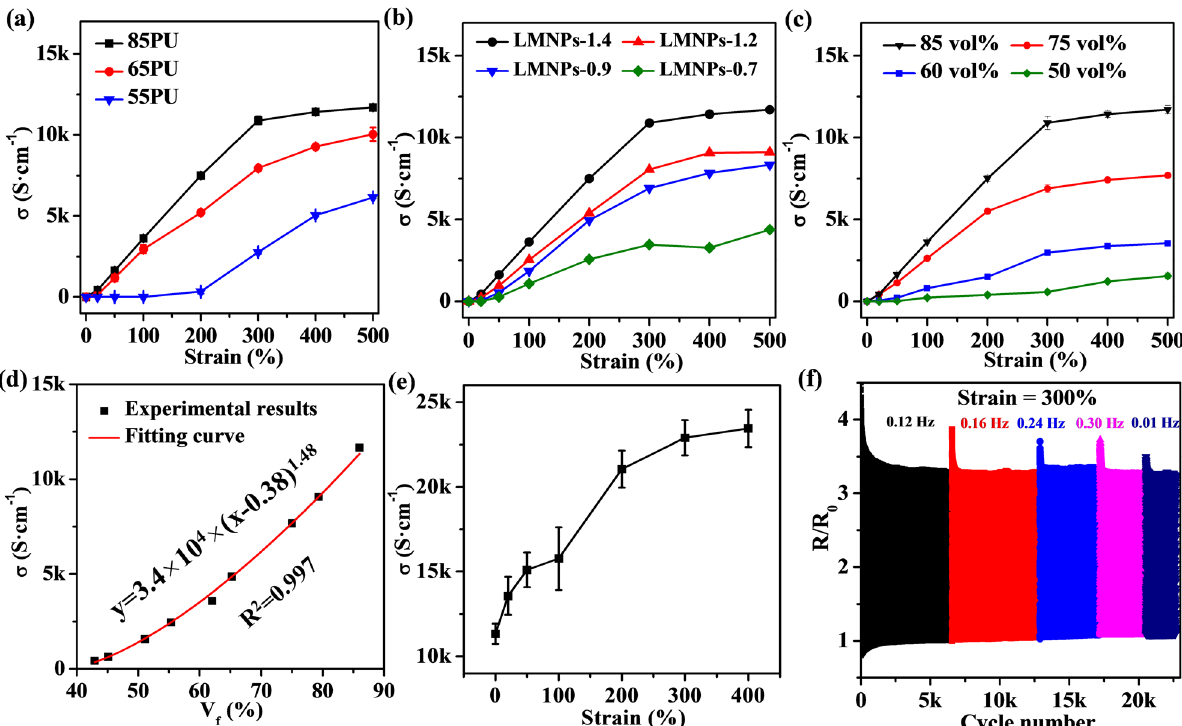
Fig. 3 Electrical performance of LM-based stretchable conductors. Relationship of conductivity in the releasing state (0% strain) after certain strains with a PU, b LMNPs diameters, and c LMNPs volume percentage. d Fitting of the experiment data with the percolation theory. e Conductivity-applied strain curve of 85%LMNPs-1.4/85PU. f Normalized resistance changes of 85%LMNPs-1.4/85PU subjection to 300% strain for 20,000 cycles at various rates (0.12, 0.16, 0.24, 0.30, and 0.01 Hz). The error bars show the standard